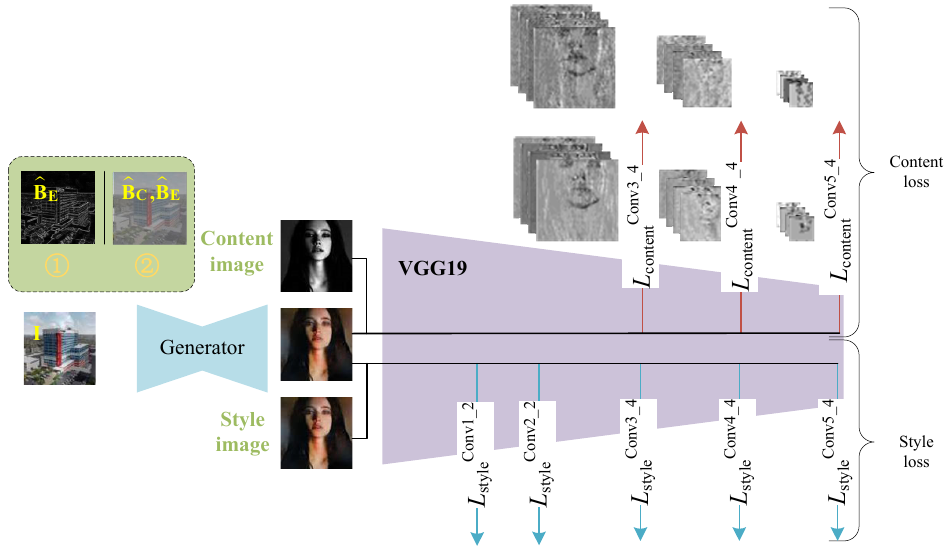
Figure 6. Content image and style image settings in a scene containing a